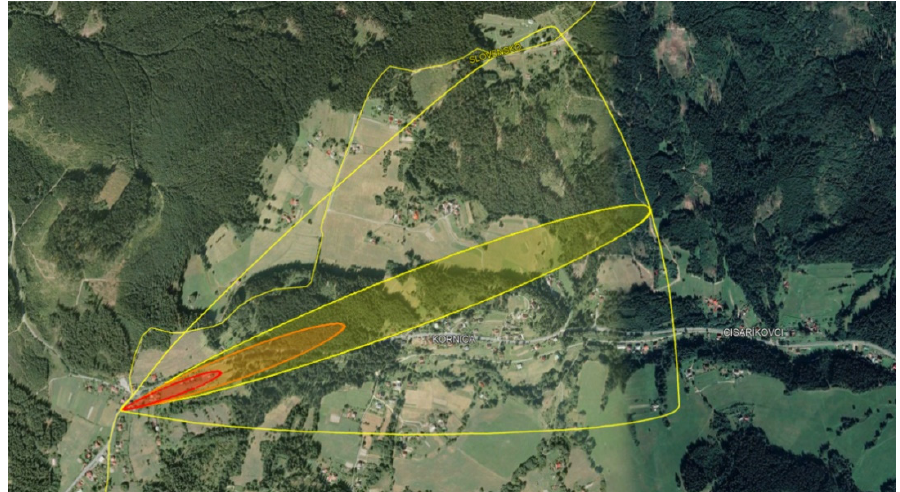
Figure 4. Graphical representation of the dispersion of a dangerous substance at the Kloko č ov-Bíla border crossing [24,25].